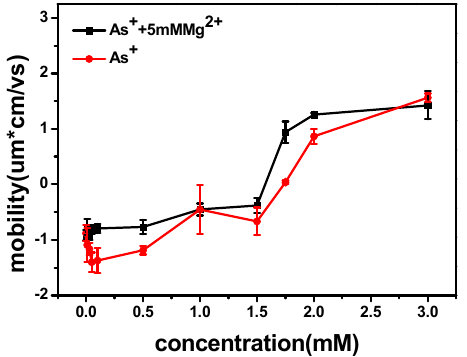
Figure 9. Electrophoretic mobility of DNA vs. the concentration of Ph 4 As + .